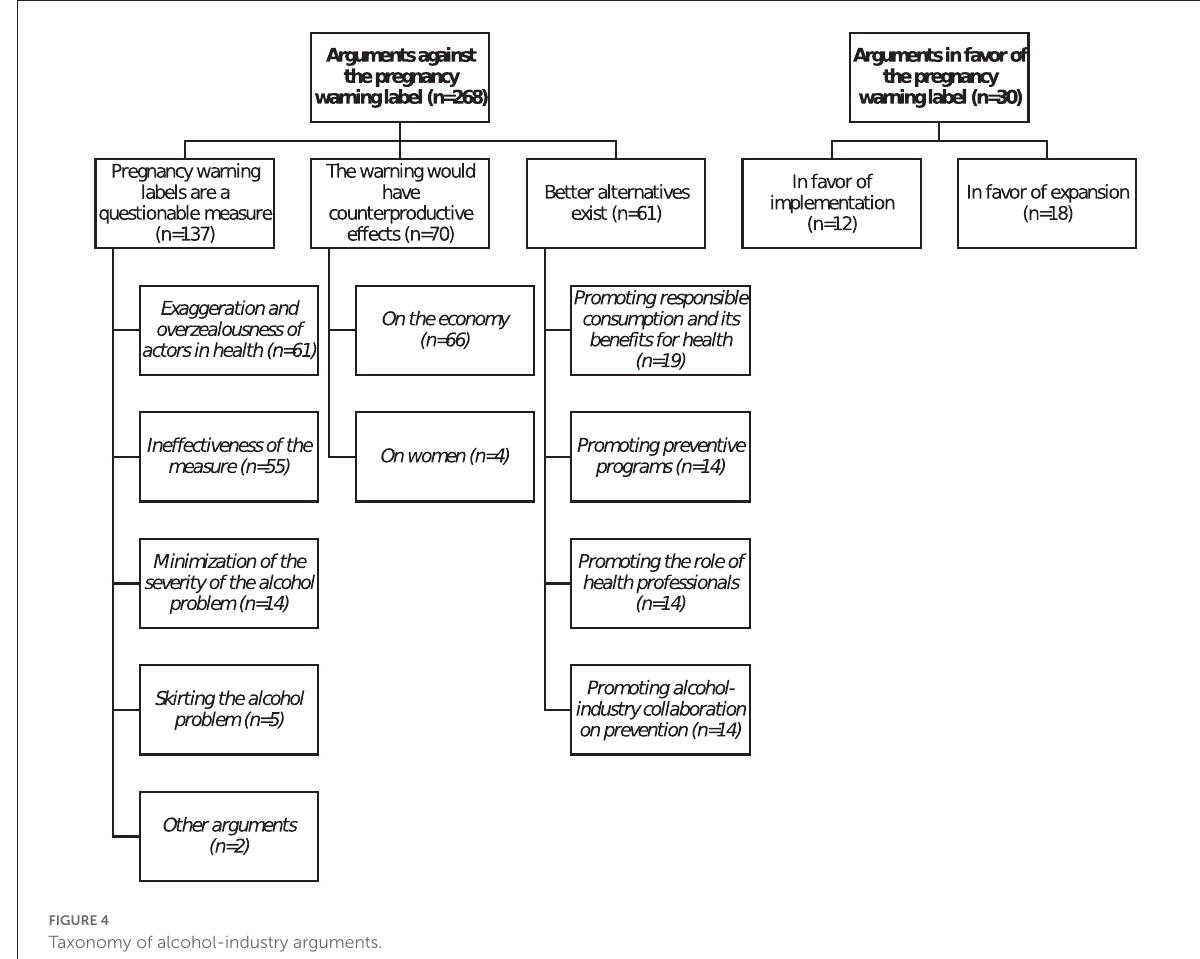
FIGURE4 Taxonomy of alcohol-industry